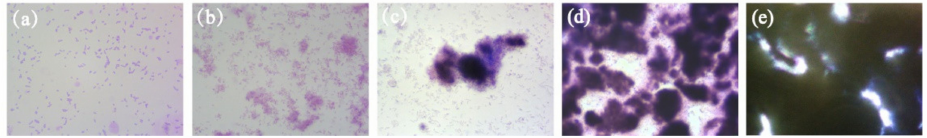
Figure 9. CLSM of E. coli exposed to GORs in 0 µ g/mL ( a ), 20 µ g/mL ( b ), 50 µ g/mL ( c ), 100 µ g/mL ( d ) and 200 µ g/mL ( e